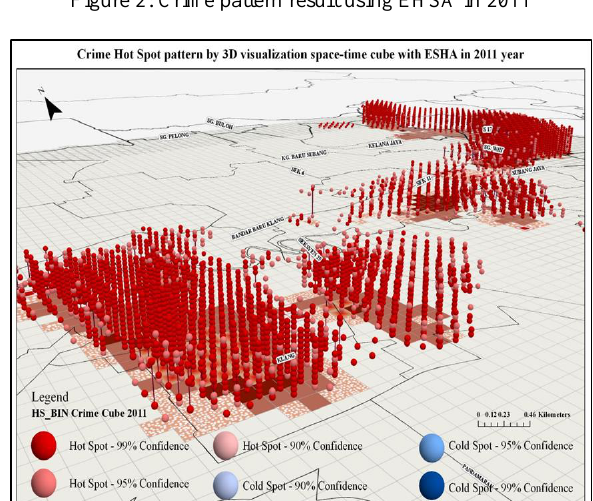
Figure 3: Crime hot spots pattern by 3D visualization in